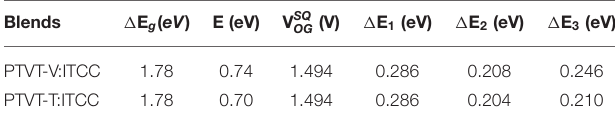
TABLE 3 | Detailed energy loss parameters of the OSCs based on PTVT-V and PTVT-T.